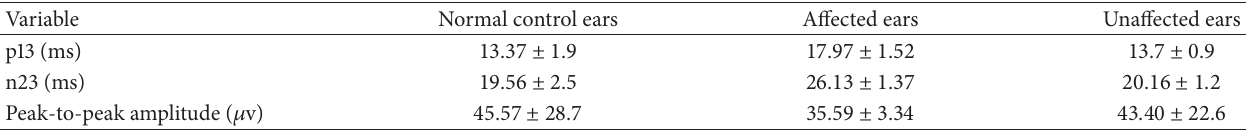
Table 1: The mean of the right and left p13-n23 latencies and amplitudes of cervical vestibular evoked myogenic potentials (cVEMPs) in the patient and the normal groups.